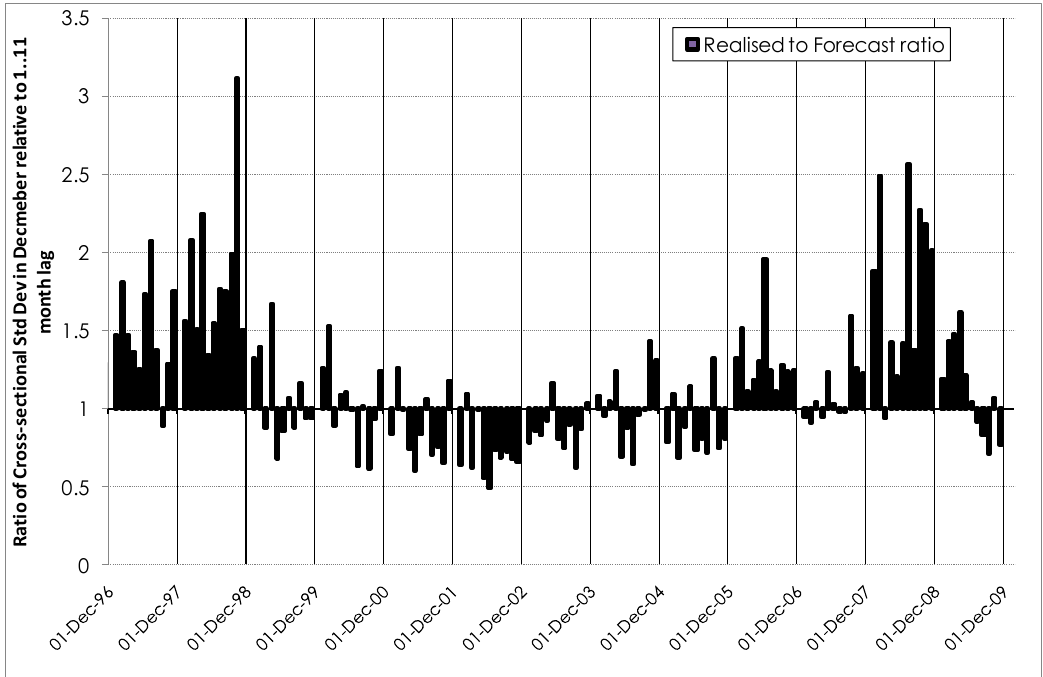
Figure 2: Realised cross-sectional standard deviation relative to increasing